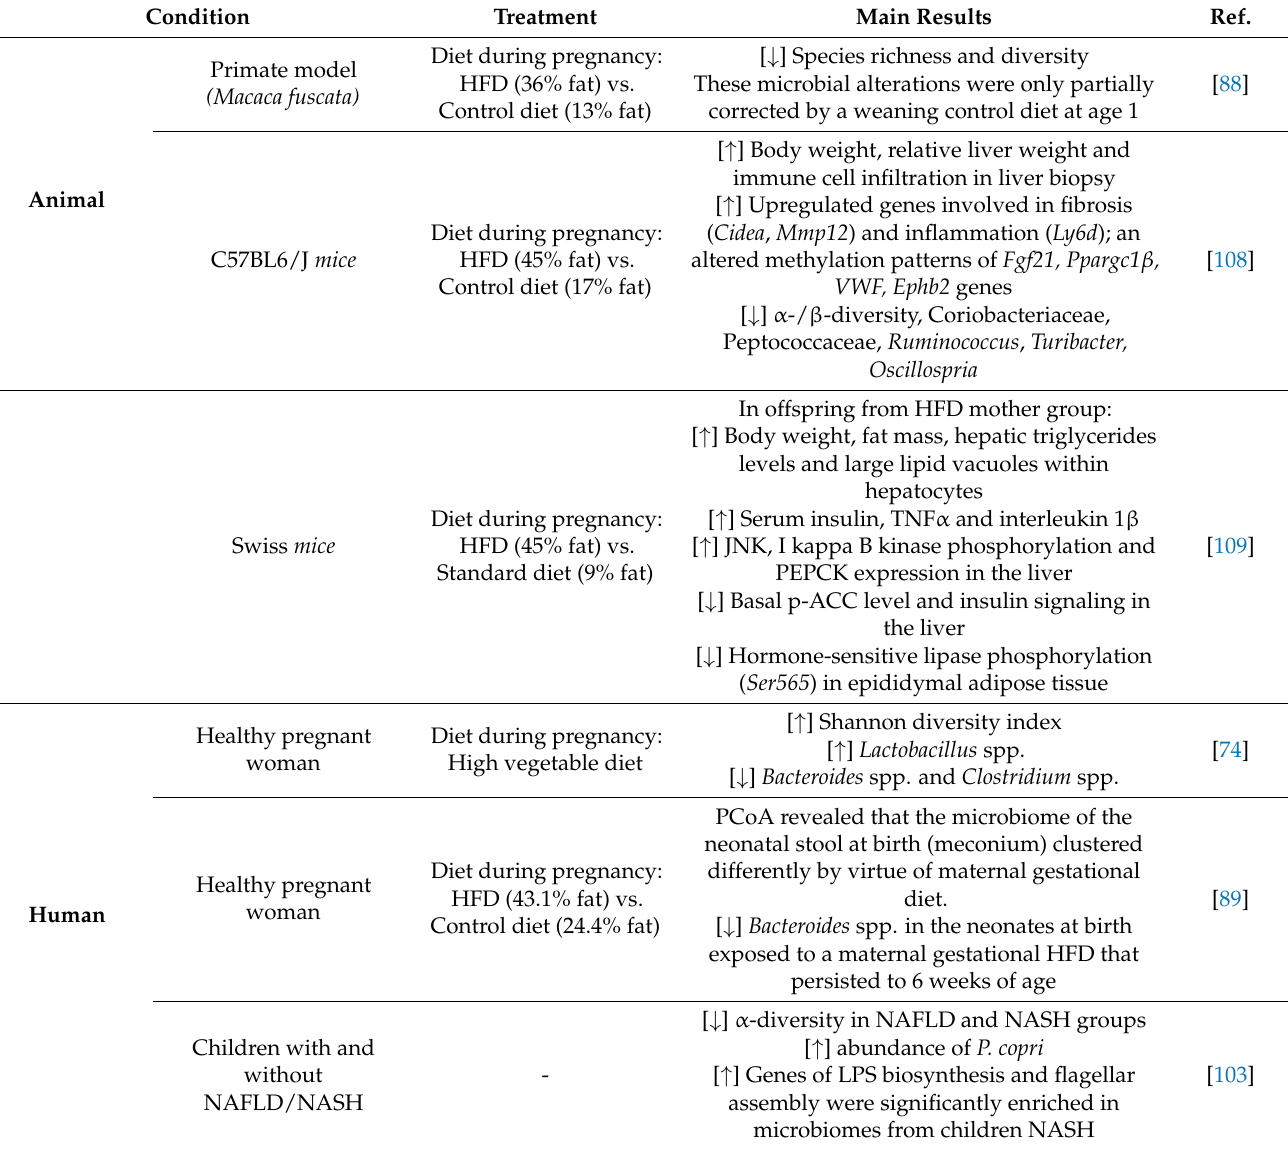
Table 1. Studies on gut microbiome dysbiosis and hepatic damage of offspring related to different nutritional exposure during intrauterine life and postnatal period. ( ↓ : reduction; ↑ increase). Condition Treatment Main Results